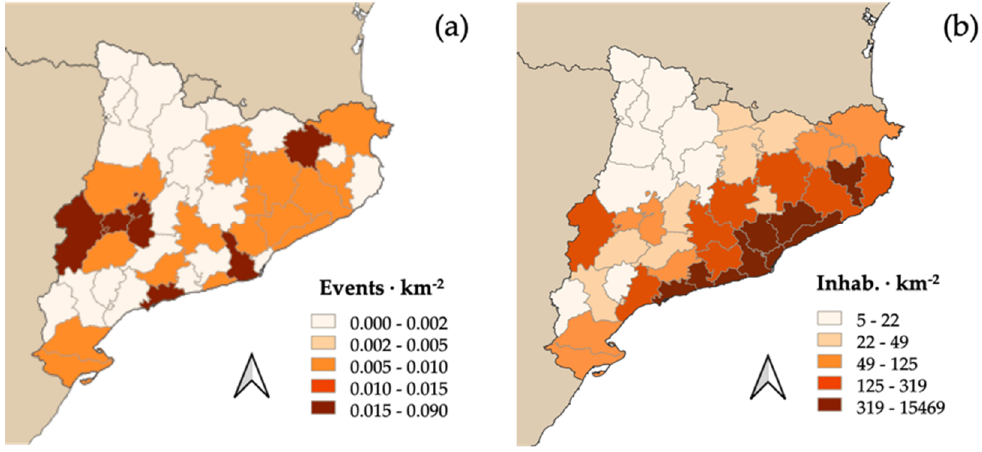
Figure 1. Geographical distribution of severe storm reports in Catalonia. ( a ) Density of severe weather events per county (events·km −2 ). ( b ) Density of population per county (inhabitants·km −2 ). Counties are indicated in grey lines. Legend categories are based on quantiles.